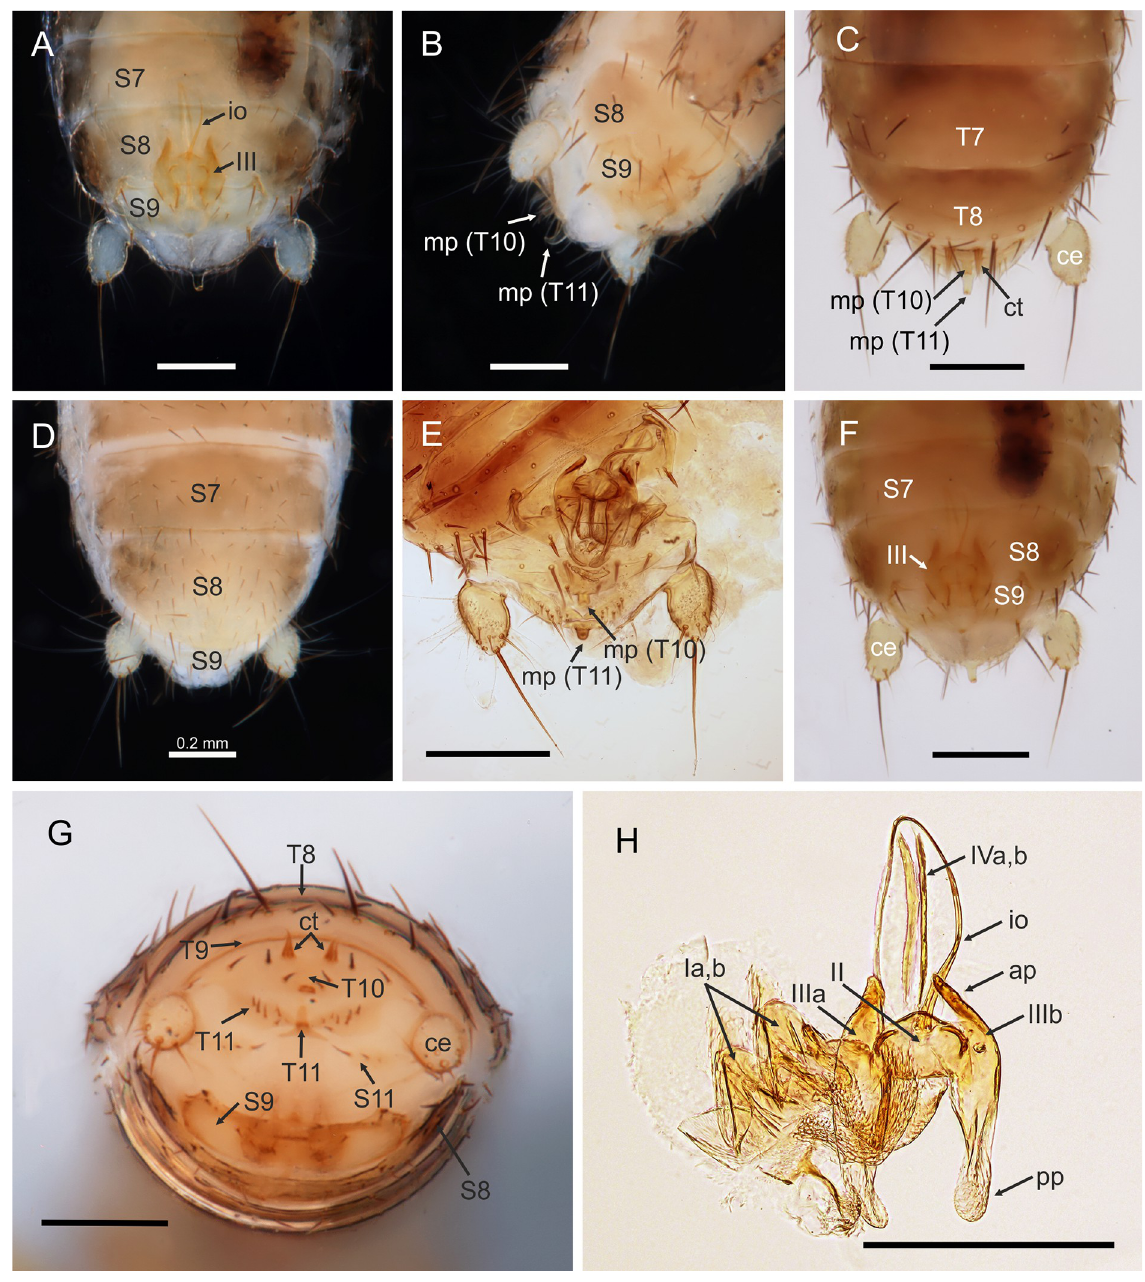
Fig 2. Latinozoros cacaoensis sp. nov., apterous male and female paratypes. A: Posterior segments of male abdomen, ventral view; B: Posterior segments of male abdomen, latero-ventral view; C: Posterior segments of male abdomen, dorsal view; D: Posterior segments of female abdomen, ventral view; E: Posterior segments of male abdomen with partly dissected genital, ventral view; F: Posterior segments of male abdomen, ventral view; G: Tip of male abdomen, posterior view; H: Dissected male genital, ventral view. Abbreviations: ap–anterior process of ventral sclerite (III) of male genital; ce–cercus; ct–ctenidium; io–intromittent organ of male genital; mp–median up-curved projection; pp– posterior process of ventral sclerite (III) of male genital; S–abdominal sternite; T–abdominal tergite; I–dorsal sclerites of male genital; II–mesal sclerite of male genital; III–ventral sclerites of male genital; IV—rod-like paired sclerites of male genital. Scale bars = 0.2 mm.